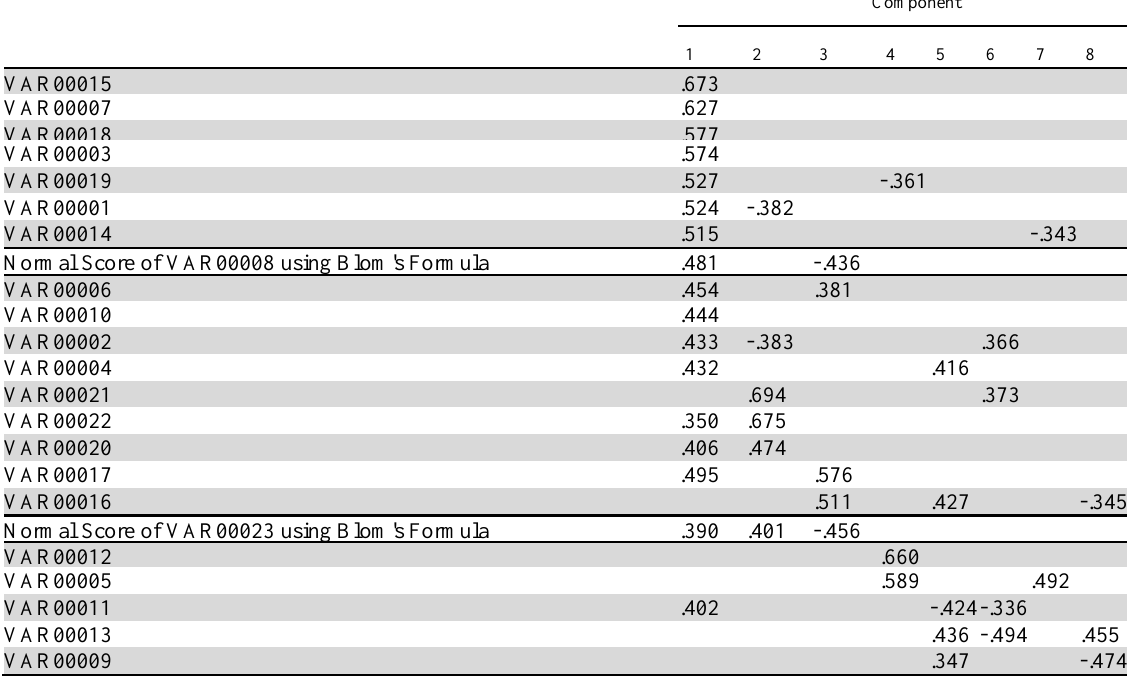
The results of Principal Component Analysis before